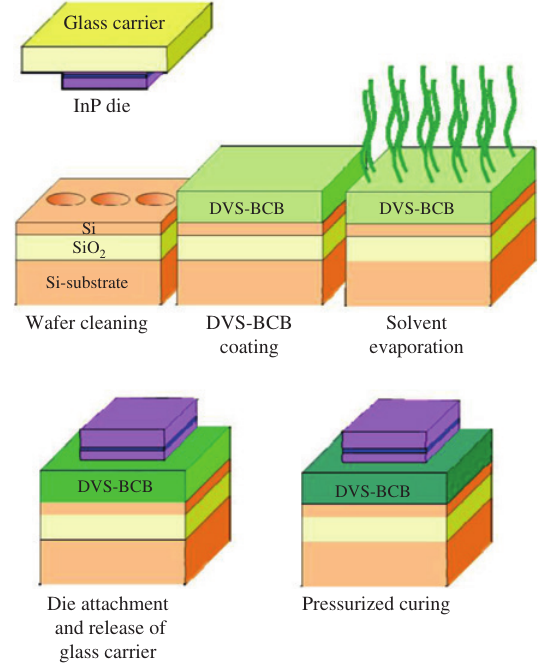
Figure 2: Schematic published by Liang et al. [2], showing an overview of DVS-BCB dye-to-wafer bonding process. DVS-BCB provides high bonding strength and quality as well as a high degree of planarization and resistance to typical chemicals used in III–V